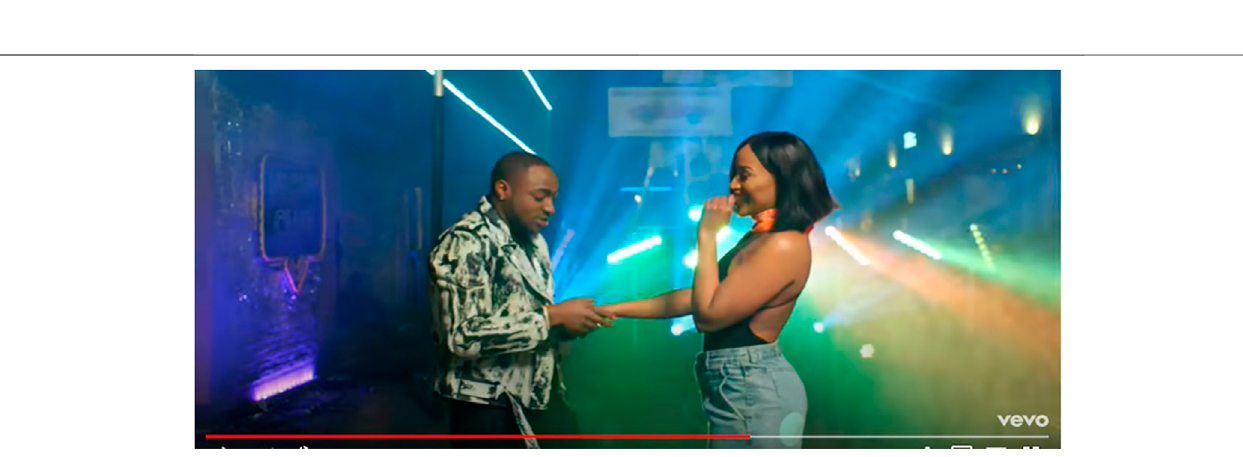
Frontiers in Sociology |